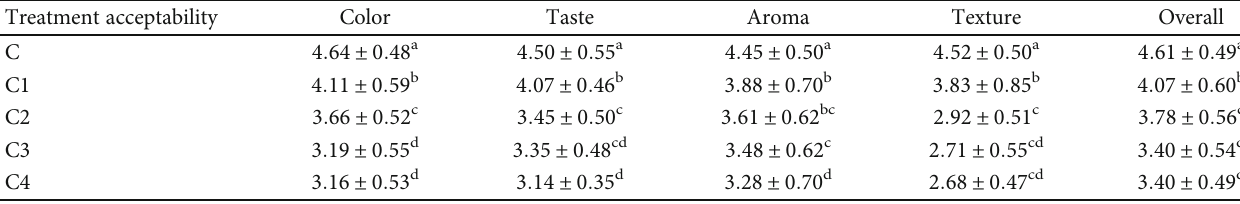
Table 3: E ff ect of blending ratio on sensory acceptability of wheat-amaranth bread. Treatment acceptability